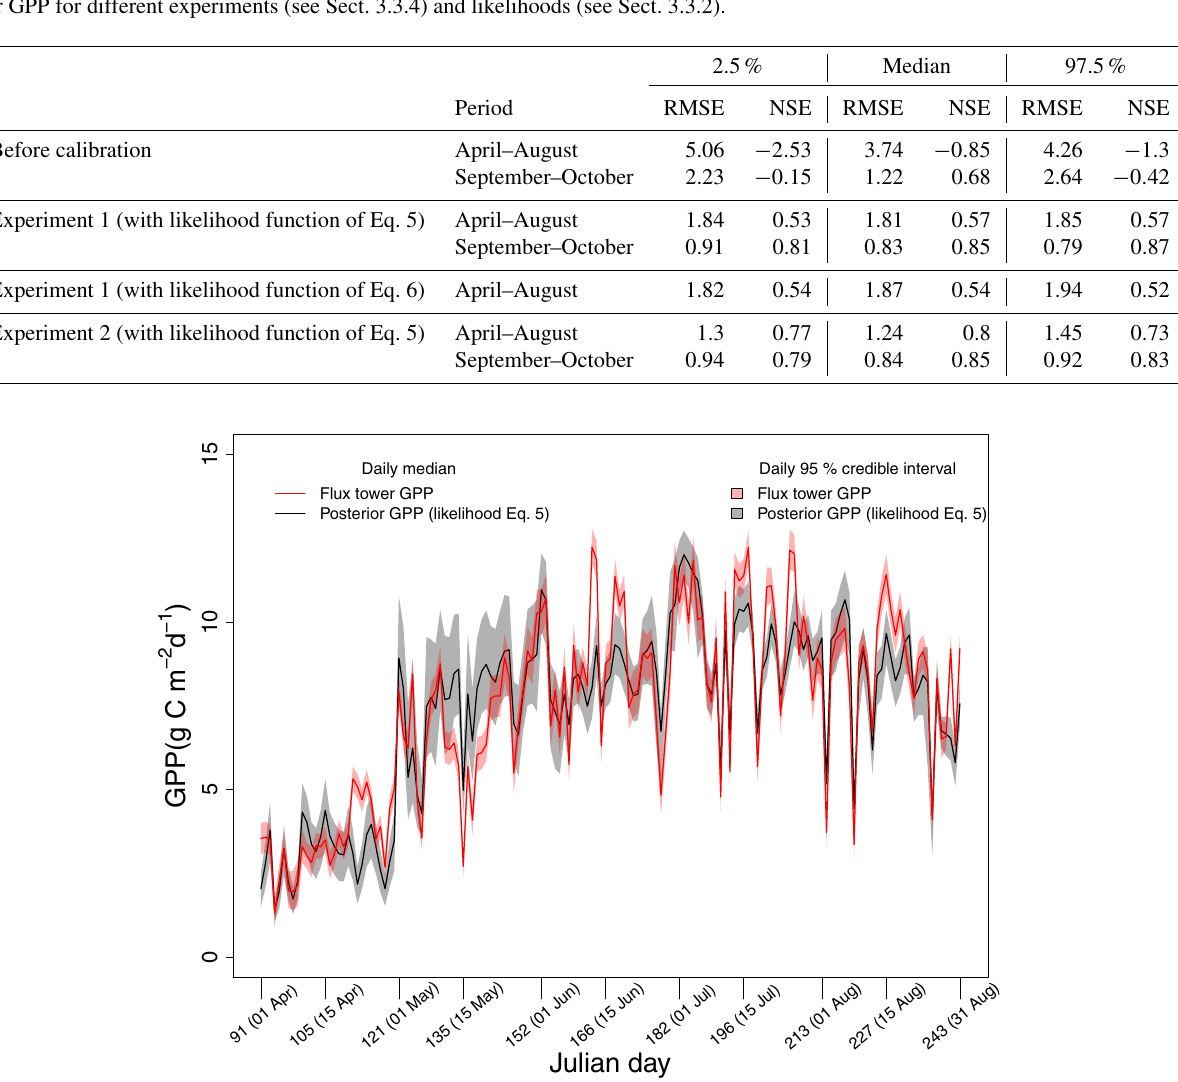
Figure 6. Temporal profile of daily posterior GPP, obtained from Experiment 2, and daily flux tower GPP for 5 months (April to August, Julian days 91 to 243). Other details are as for Fig.